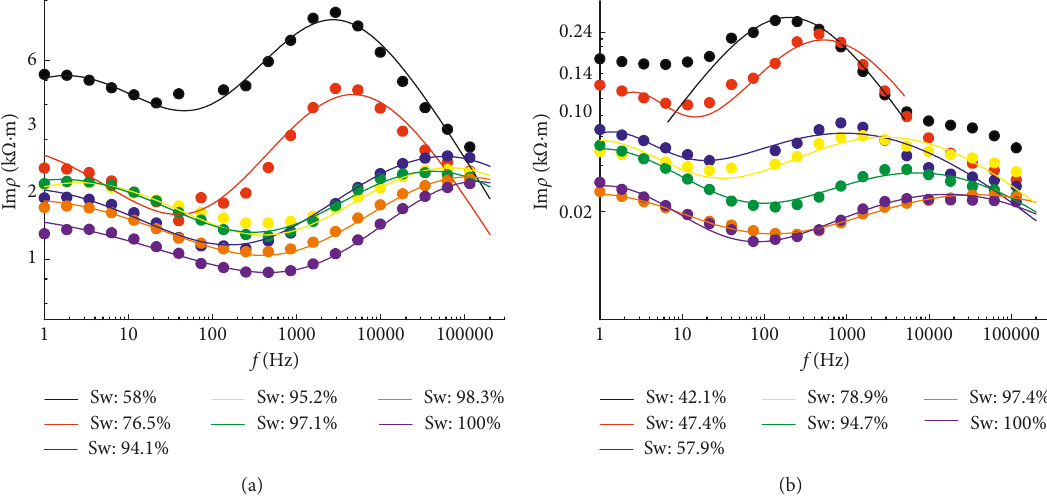
Figure 5: The Im ρ curves of (a) bituminous coal and (b) anthracite are fitted by the double Cole-Cole model.